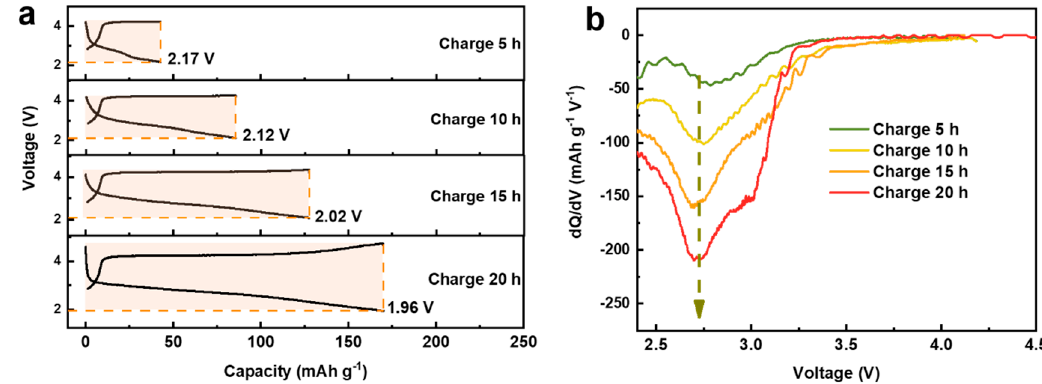
Figure 4. ( a ) The controllable charge/discharge curve as a function of charging time. ( b ) The dQ/dV curves for the corresponding discharge curves.